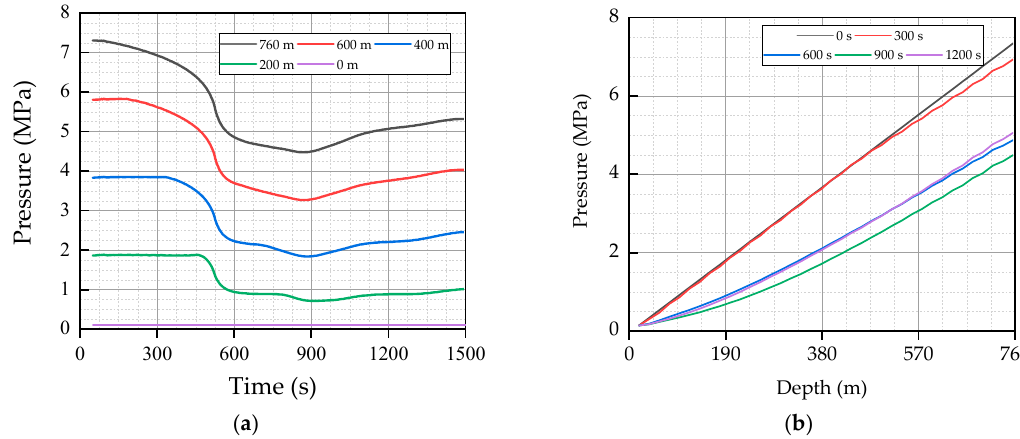
Figure 13. Variation in annular pressure at different: ( a ) times; and ( b ) depths.